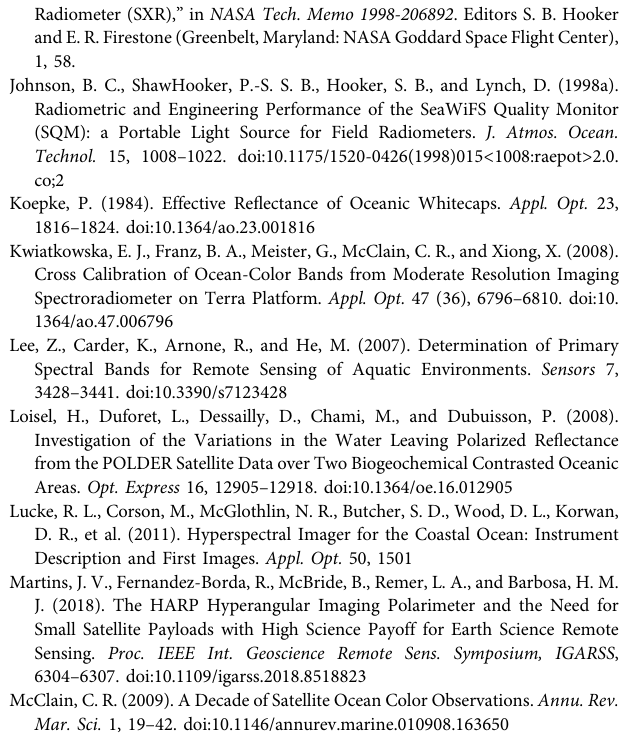
Algorithm. Appl. Opt. 33, 443 – 452. doi:10.1364/ao.33.000443 Gould, R. W., and Arnone, R. A. (1998). Remote Sensing Estimates